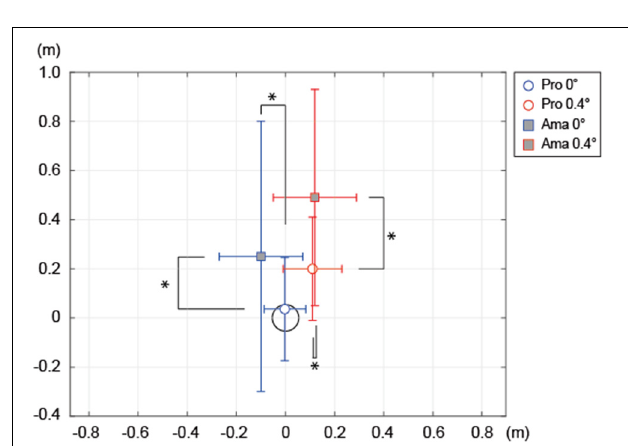
FIGURE 9 | Average constant errors in final ball position for each group. The circle in coordinate (0, 0) represents the target. Both the vertical and horizontal axes indicate the distance (m). The positive values on the horizontal axis mean that the FBP was to the right of the target’s center, while the negative values indicate that the FBP was to the left of the target’s center. The positive values on the vertical axis signify that the FBP was overshot from the target’s center, while the negative values on the vertical axis indicate that it was undershot. * p <